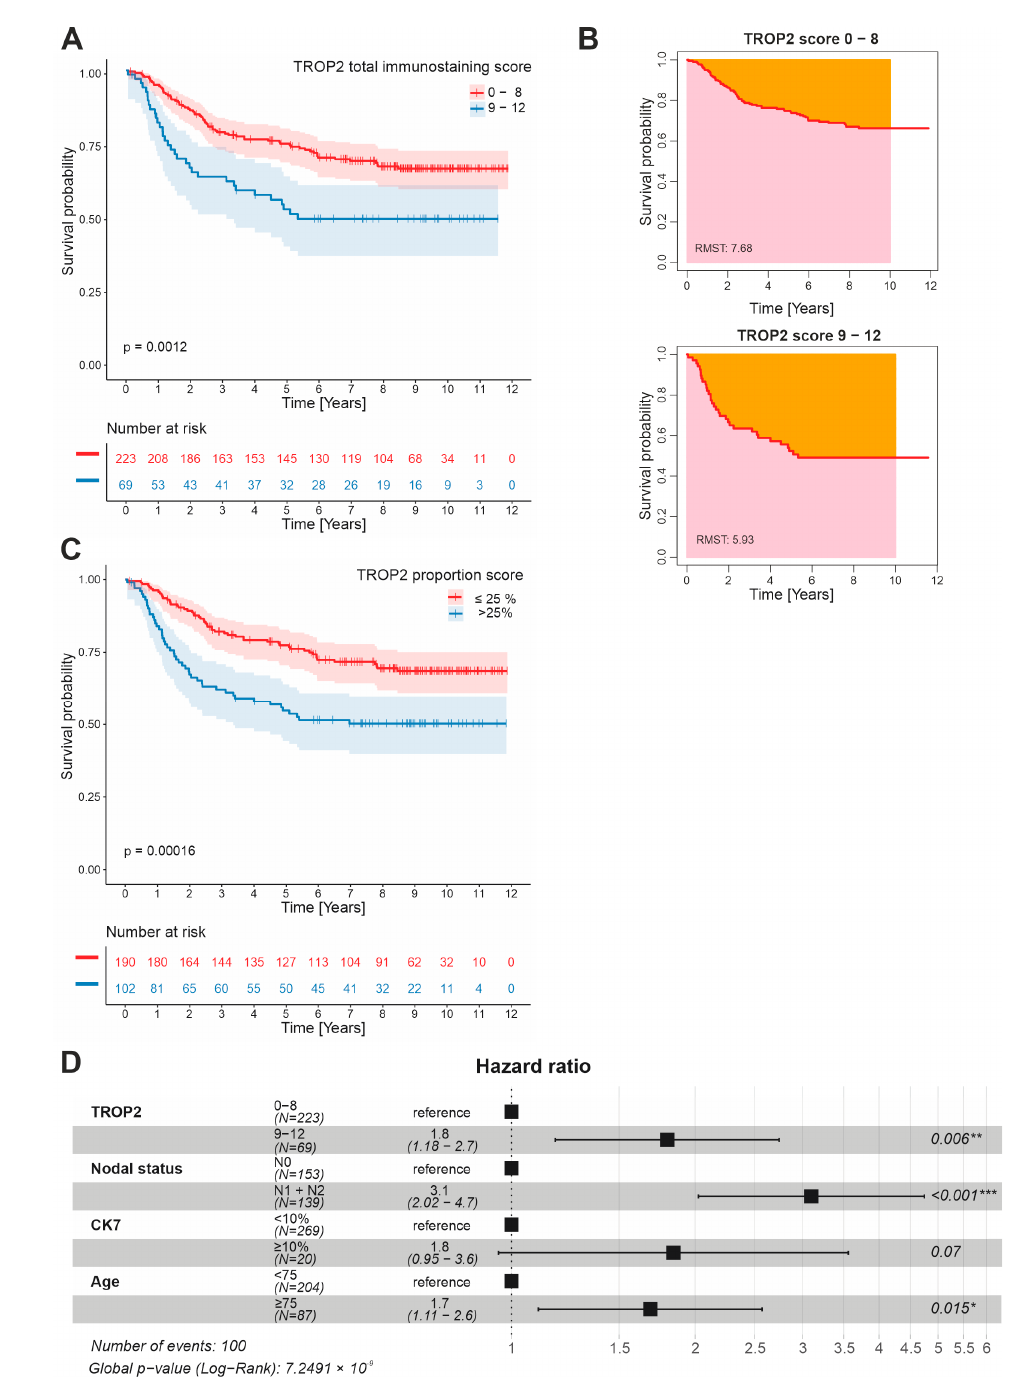
Figure 2. Analysis of cancer-specific survival and prognostic significance of TROP2 in 292 patients with colorectal cancer. ( A ) Kaplan–Meier survival curves calculated for groups with high (score 9–12) and low/medium (score 0–8) TROP2 expression showed poorer survival in patients with TROP2 overexpression. ( B ) Restricted mean survival time (RMST) is significantly shorter in the high TROP2 expression group than in the low/medium score group (5.93 vs. 7.68 years, p = 0.0012). ( C ) Kaplan–Meier analysis based on the TROP2 proportion score showed poor prognosis in patients with ≥ 25% positively stained TROP2 cancer cells ( p = 0.00016). ( D ) Forrest plot showing significant results of multivariate Cox regression identifying high TROP2 expression as an independent negative prognostic factor in patients with CRC ( p = 0.006) along with lymph node involvement ( p < 0.001) and age ≥ 75 years ( p = 0.015); CK7—cytokeratin 7; * p < 0.05; ** p < 0.01; *** p <